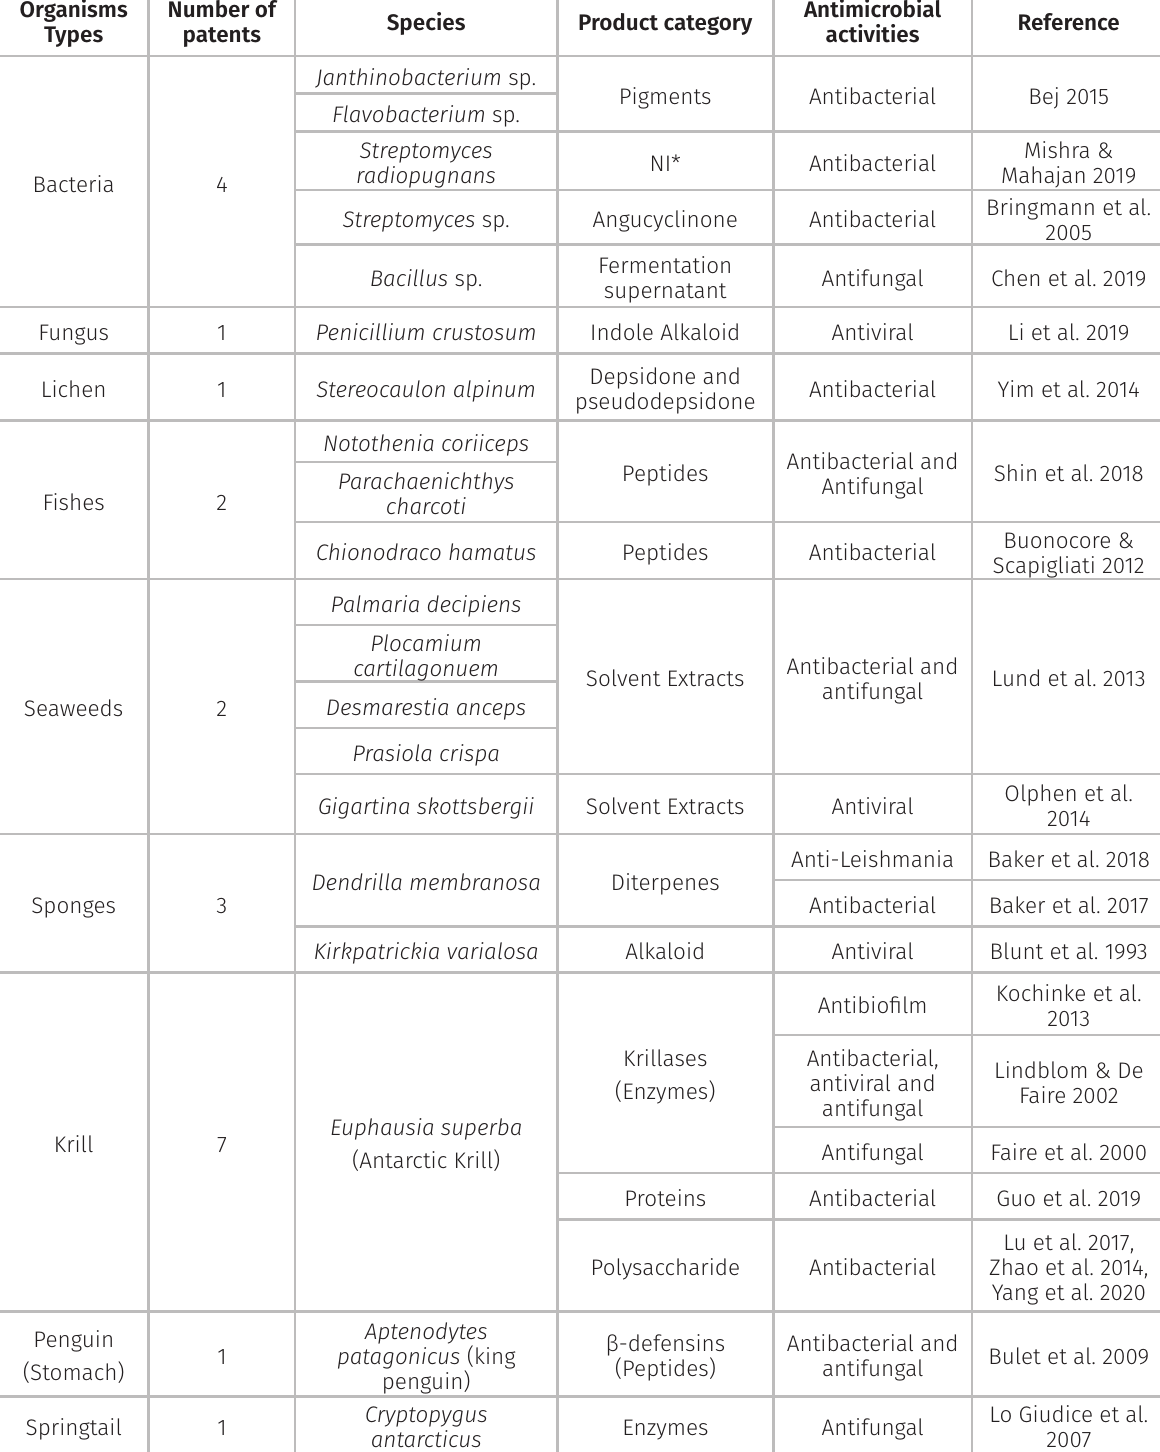
Table II. Phylogenetic distribution of the antarctic organisms referred to as source of compounds with antimicrobial activity in the patent